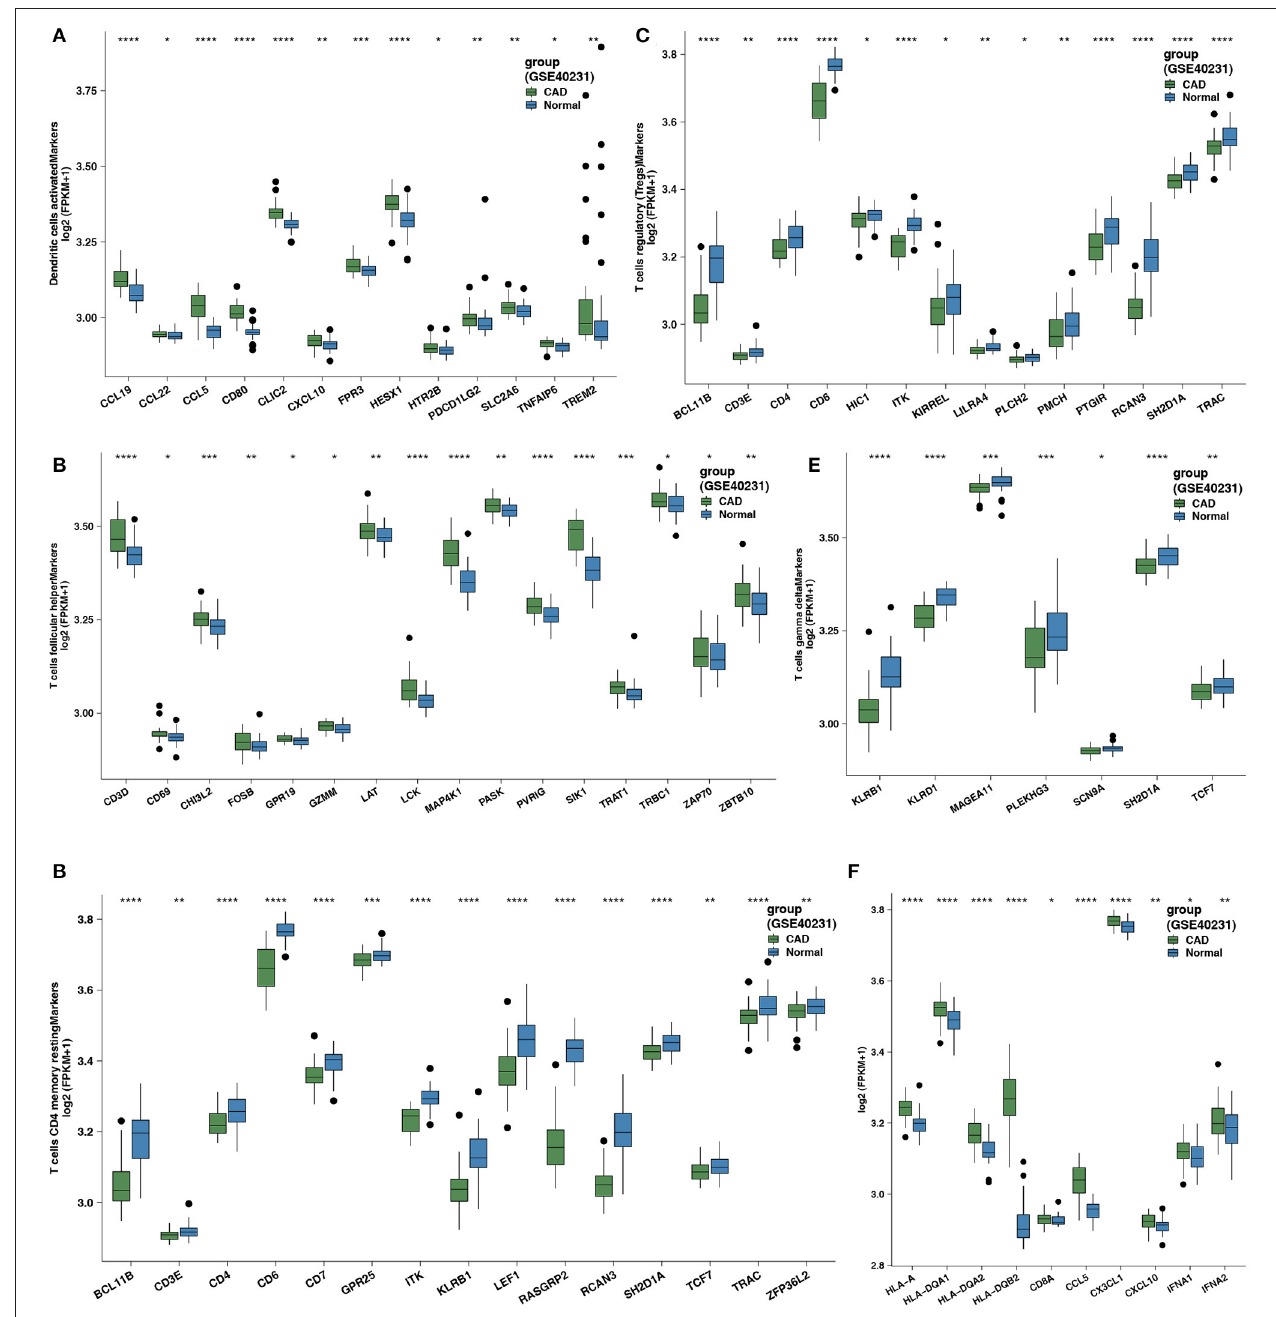
FIGURE 2 | (A) Comparison of the expression of cell markers of activated DCs between the CAD cases vs. the healthy controls in GSE40231. (B) Comparison of the expression of cell markers of Tfhs between the CAD cases vs. the healthy controls in GSE40231. (C) Comparison of the expression of cell markers of Tregs between the CAD cases vs. the healthy controls in GSE40231. (D) Comparison of the expression of cell markers of resting CD4 + T cells between the CAD cases vs. the healthy controls in GSE40231. (E) Comparison of the expression of cell markers of γδ T cells between the CAD cases vs. the healthy controls in GSE40231. (F) Comparison of the expression of CYT-related, antigen-presentation, and proinflammatory-related genes (chemokine and cytokine) between the CAD cases vs. the healthy controls in GSE40231. DCs, dendritic cells; CAD, coronary artery disease; CYT, cytochrome; Tfhs, T follicular helper cells; Tregs, regulatory T cells; γδ T cells, gamma delta T cells. Wilcoxon signed-rank test: **** P < 0.0001; *** P < 0.001; ** P < 0.01; * P < 0.05. correlation. The γδ T cells negatively correlated with